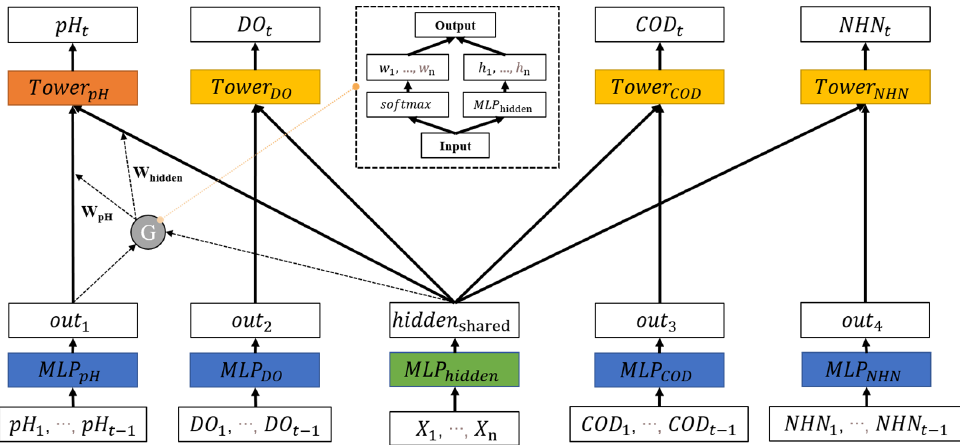
Figure 5. Gated hidden parameter sharing structure of multi-indicator water quality prediction.